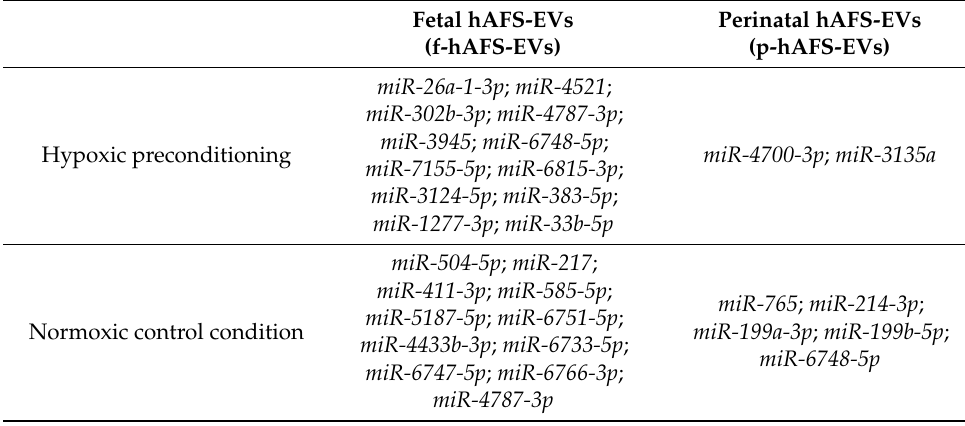
Table 1. miRNAs modulated within